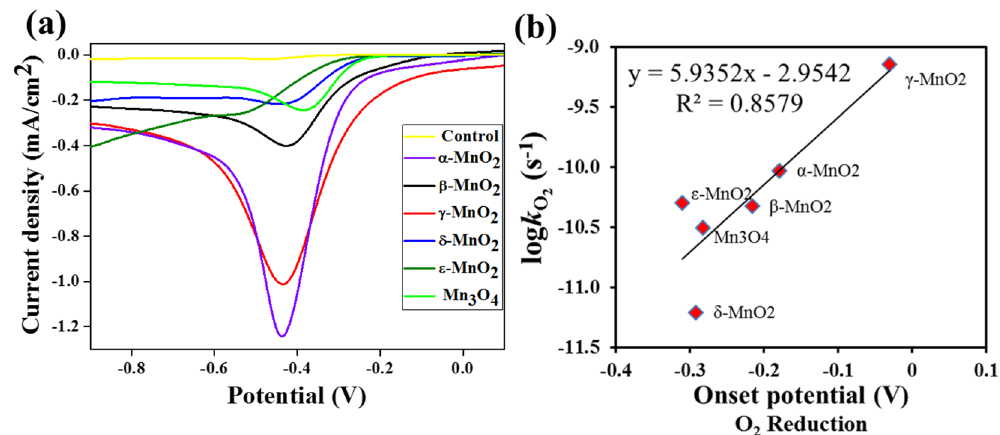
Figure 6. ( a ) Linear sweep voltammetry (scan rate of 20 mV/s) of O 2 on glassy carbon electrode coated with different MnO x in acetate buffer at pH 6.0 containing 1.0 M KCl. ( b ) The correlation between the log k O2 of ABTS oxidation and the onset potential of O 2 reduction with different MnO x